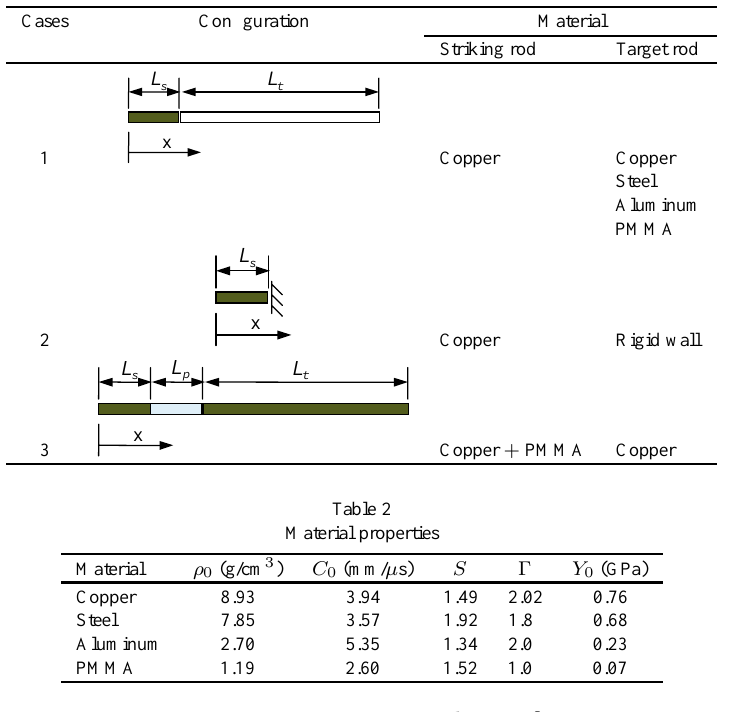
Table 1 Geometry of striking and target rods and coordinate system used for the three